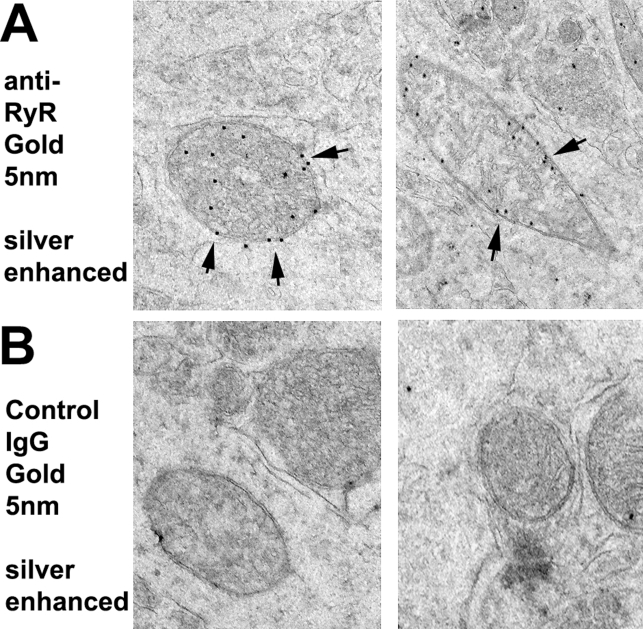
RyR are located in the inner mitochondrial membrane.A, Neuronal RyR expression (short arrows) is contiguous with the inner mitochondrial membranes (IMM) from rodent brain as visualized by silver-enhanced immunogold cytochemistry. B, Control sections were incubated with gold-labeled secondary antibodies in the absence of primary antibody and demonstrate no appreciable, non-specific staining.